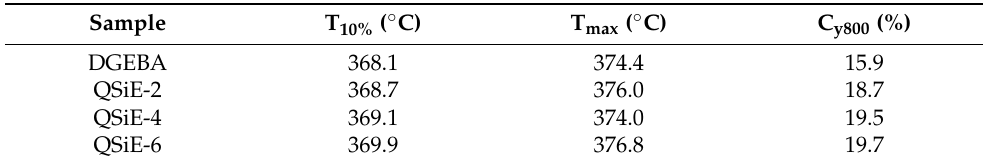
Figure 2. TG ( a ) and DTG ( b ) curves of cured thermosets, photos of samples ( c ) after TGA tests. Table 1. Thermogravimetric data of cured thermosets.